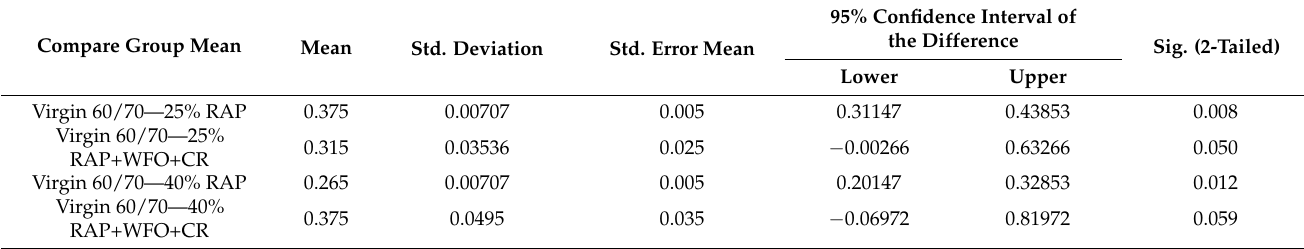
Table 6. Comparison of significant difference of group means for the PI